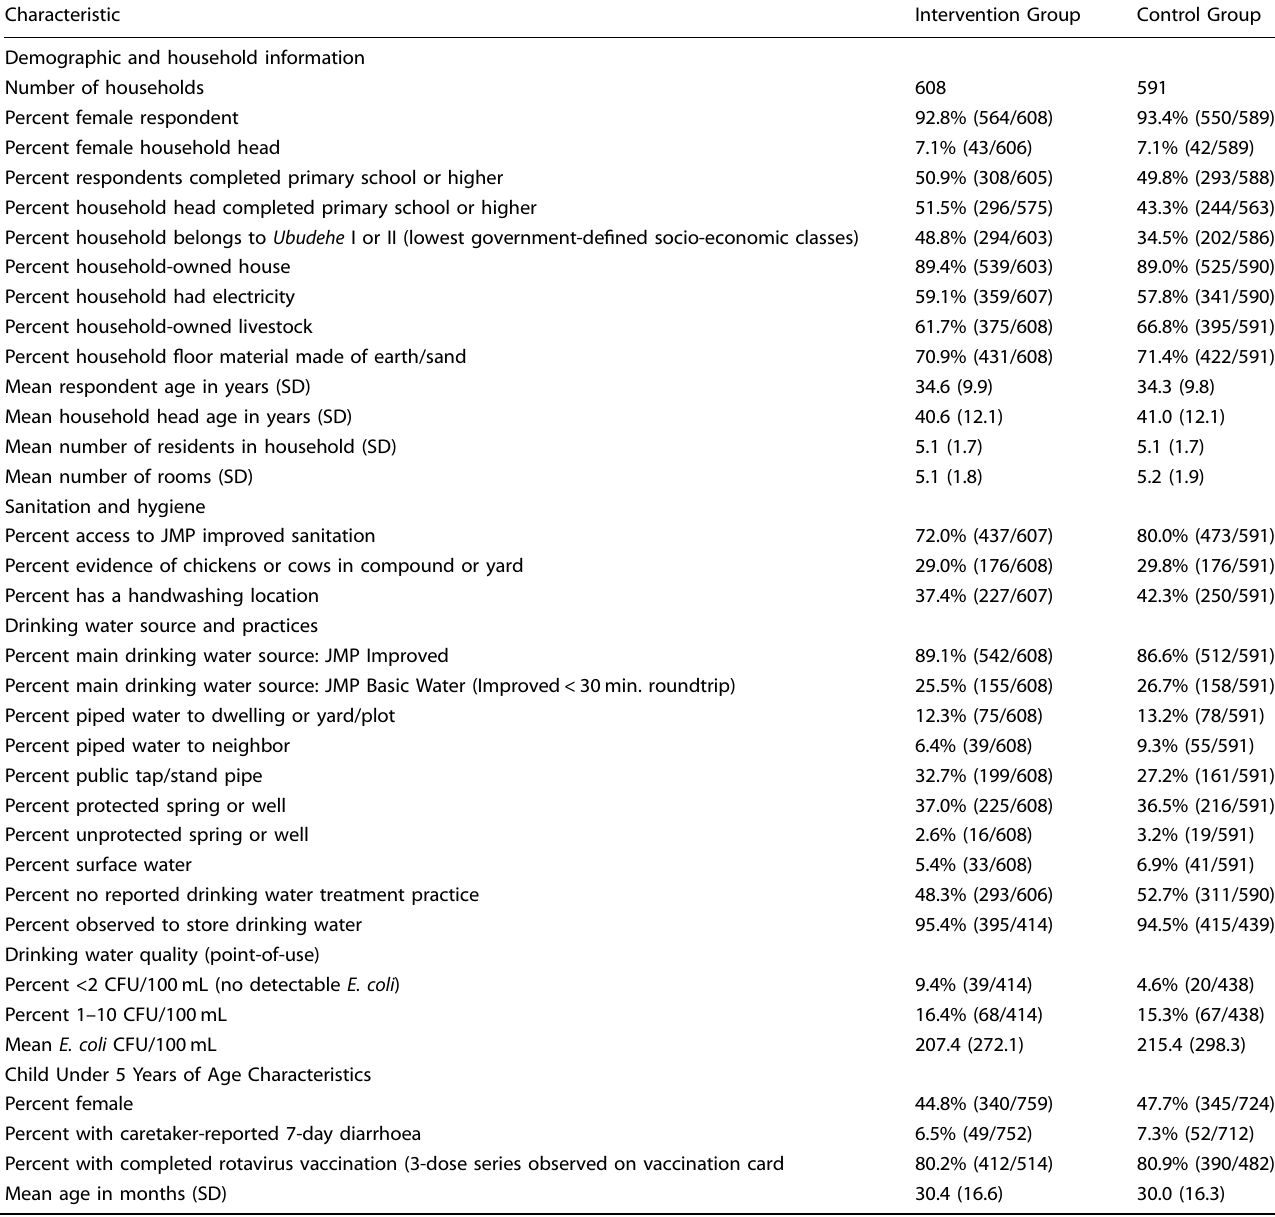
Table 1. Household and child characteristics at baseline by study arm.